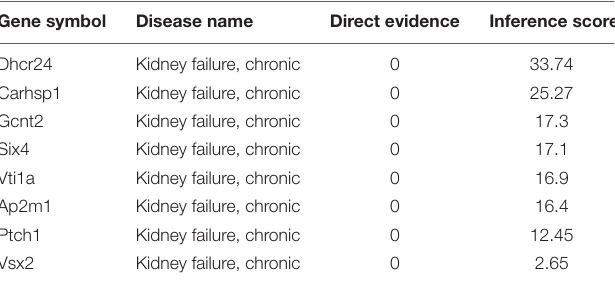
TABLE 2 | CTD database assesses the inference score of targeting mRNAs in chronic renal disease. Gene